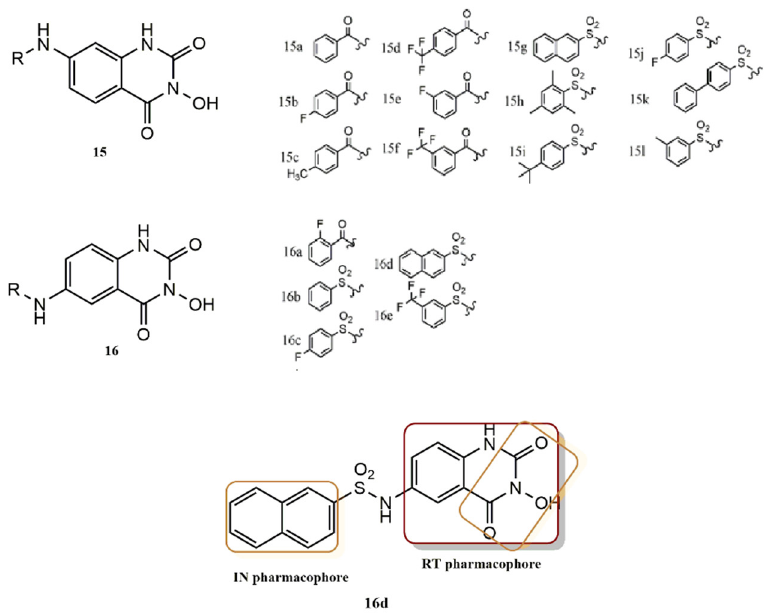
Figure 17. RT and IN pharmacophores of new active synthesized compounds 15a-l and 16a-e